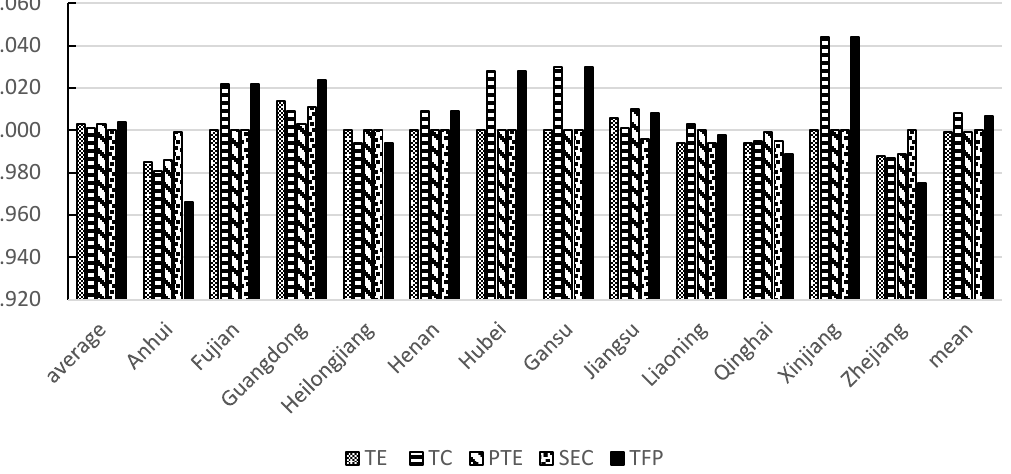
Figure 4. Efficiency changes in large-scale raw milk production areas in China from 2004 to